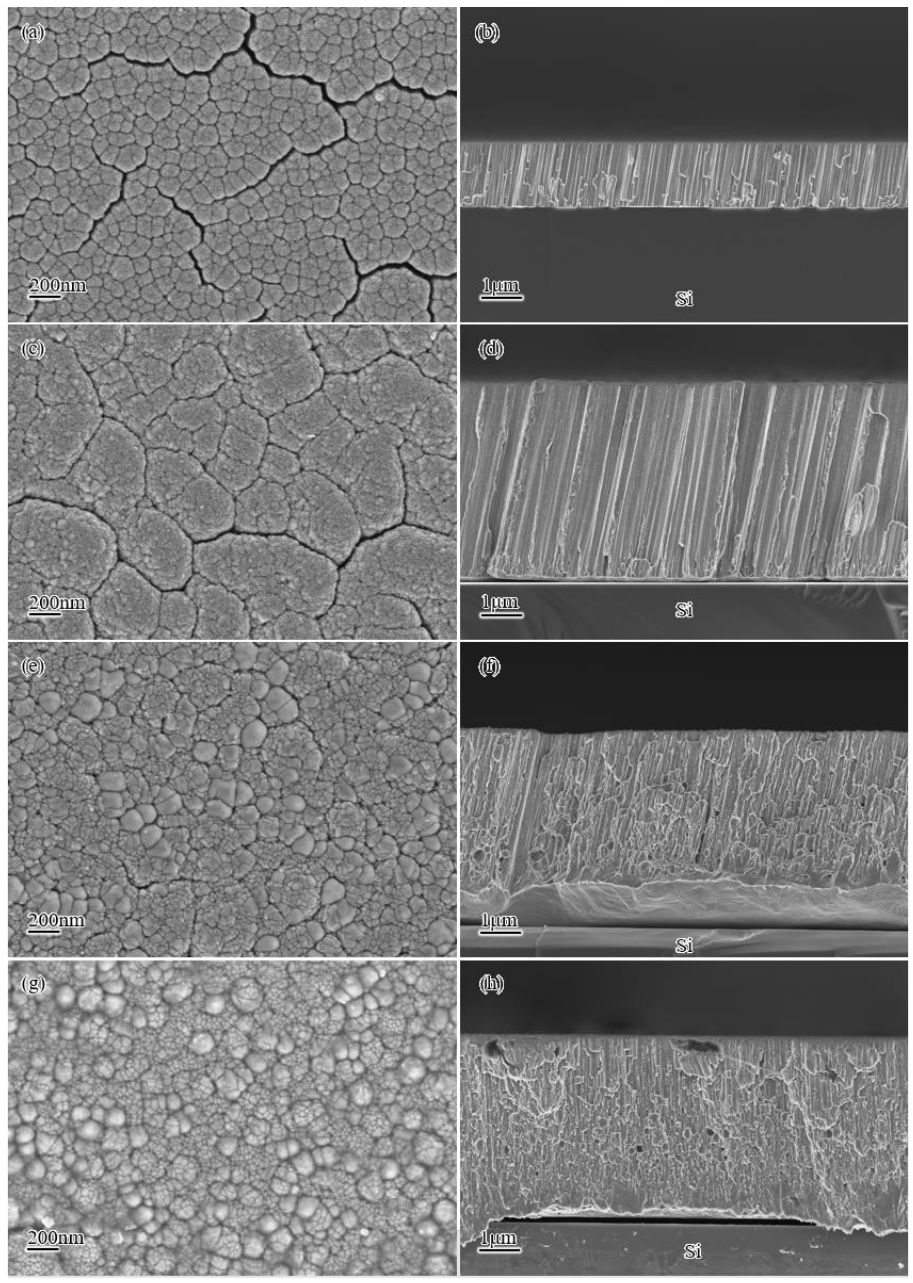
Figure 7. Surface and cross-section morphology of Cu films at different peak currents: ( a , b ) 2 A, ( c , d ) 8 A, ( e , f ) 13 A, and ( g , h ) 18